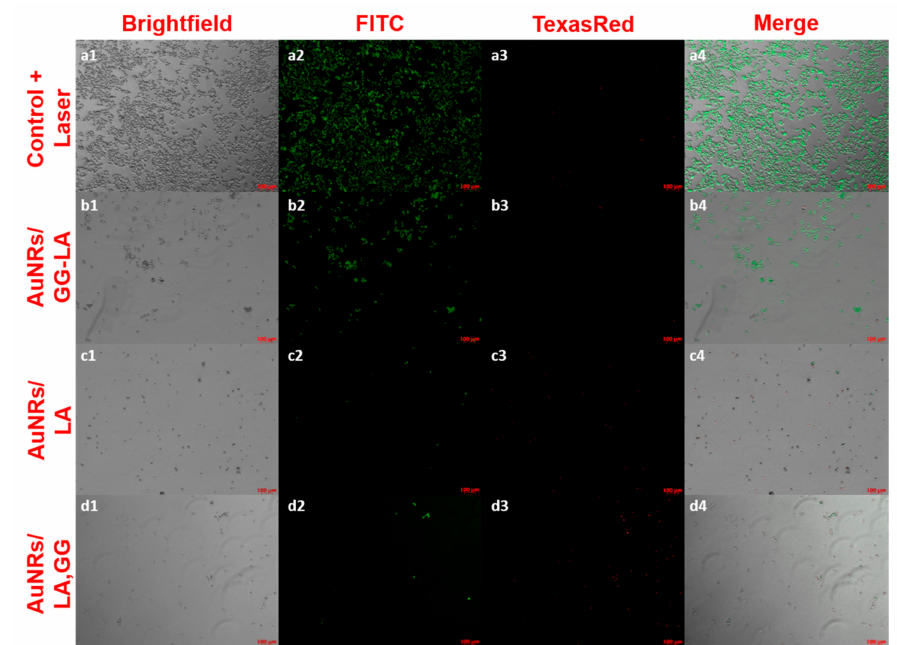
Figure 9. LIVE / DEAD assay fluorescence microscopy images on laser-treated HCT116 cell culture (810 nm, 10 × 10 − 3 W / mm 3 , and 100 s). Here, 5 × magnifications of: control + laser ( a ), AuNRs / GG-LA ( b ), AuNRs / LA ( c ), and AuNRs / LA,GG ( d ) are used. Acquisition channels: brightfield (1), fluorescein isothiocyanate (FITC) (2), Texas Red (3), and merge (4); scale bar: 100 µ